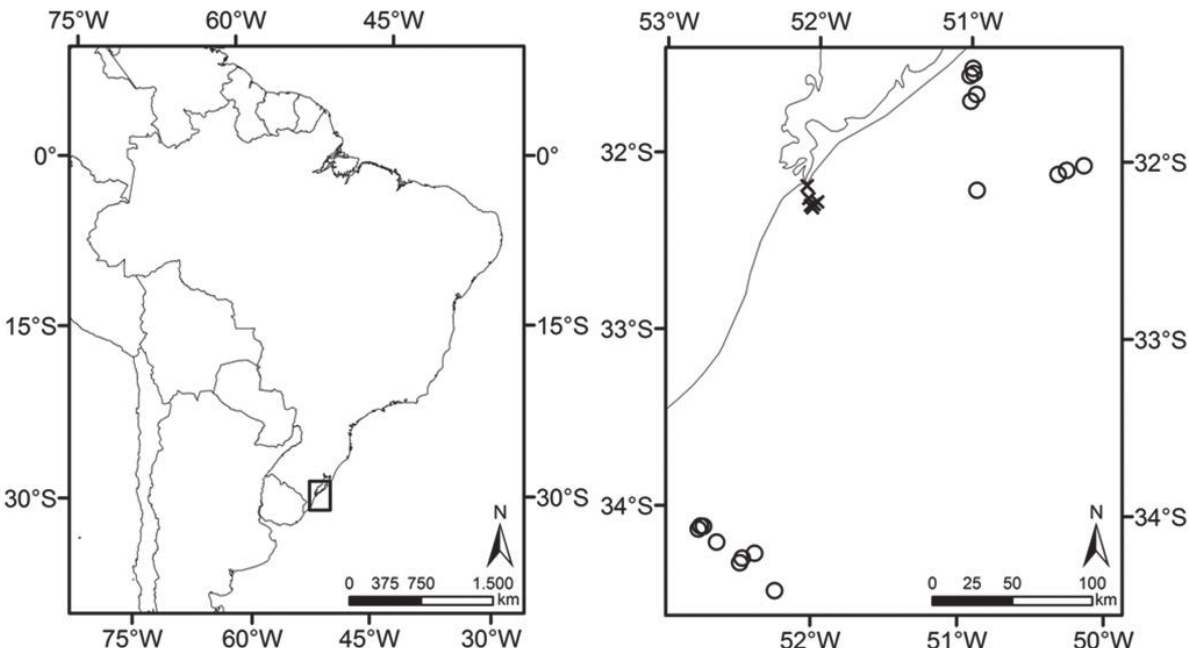
Fig. 1. Map of the study area. Left map represents South America. The square is a detail of the study area. The right map represents south of Brazil indicating the trawling stations where the specimens of Sympterygia were captured; research cruises of the research vessel “Larus” (triangles) and commercial bottom trawl fishing trips